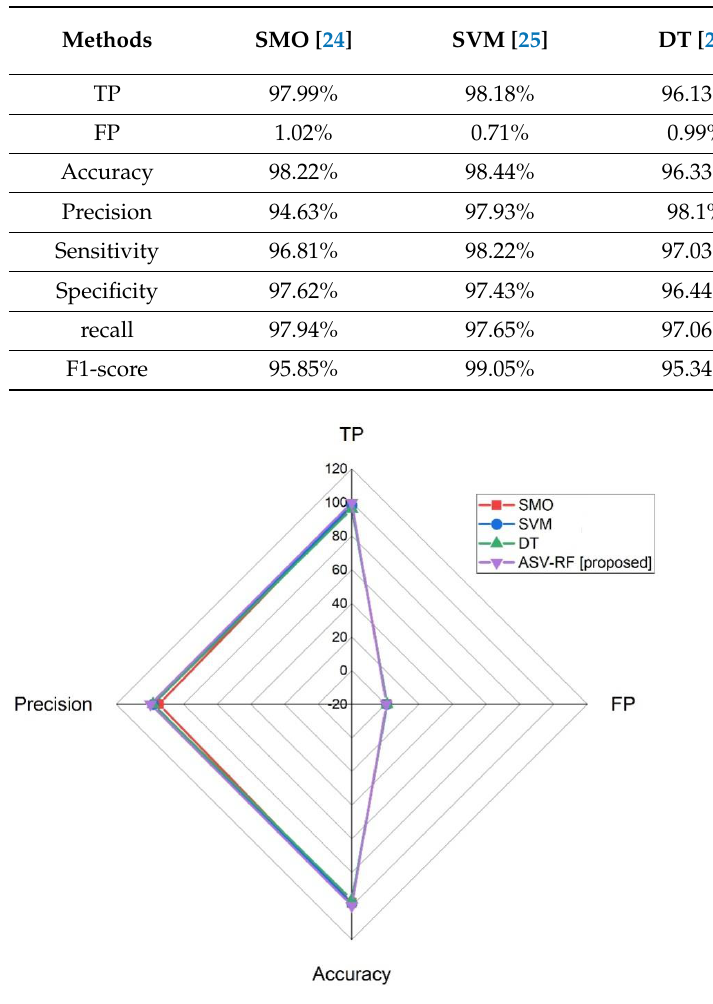
Figure 4. Results of TP, FP, accuracy, and precision metrics.